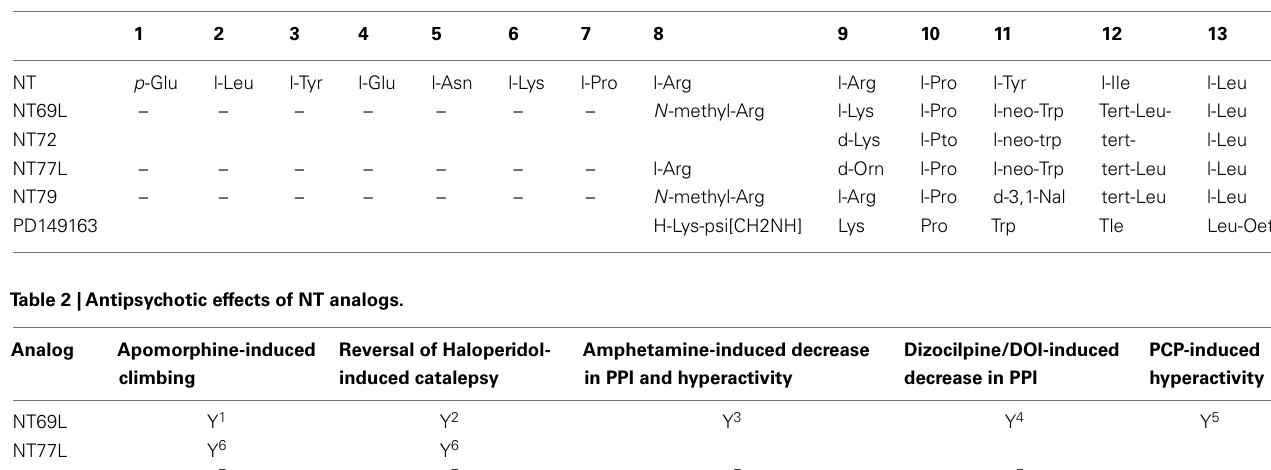
Table 1 | Structures of NT analogs.